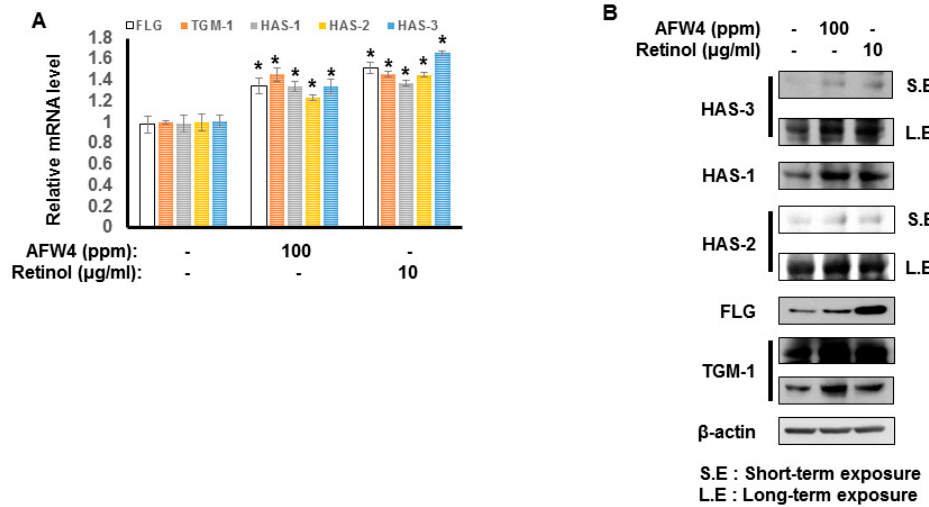
Figure 4. Effect of AFW4 on the expression of NMF-related genes. HaCaT cells were incubated with AFW4 for 48 h. Afterward, the cells were harvested and subjected to real-time RT-PCR analysis ( A ) and Western blotting ( B ) to analyze mRNA and protein expression levels of NMF-related genes, respectively. Retinol was used as a control compound. The results were confirmed using four independent experiments. Each experiment was conducted in duplicate. All data are presented as the mean ± SEM of four independent experiments. Statistical significance of differences among the groups was assessed by ANOVA, followed by Tukey’s multiple-comparison test, using the GraphPad Prism 5 software. * p < 0.05 vs. control group.